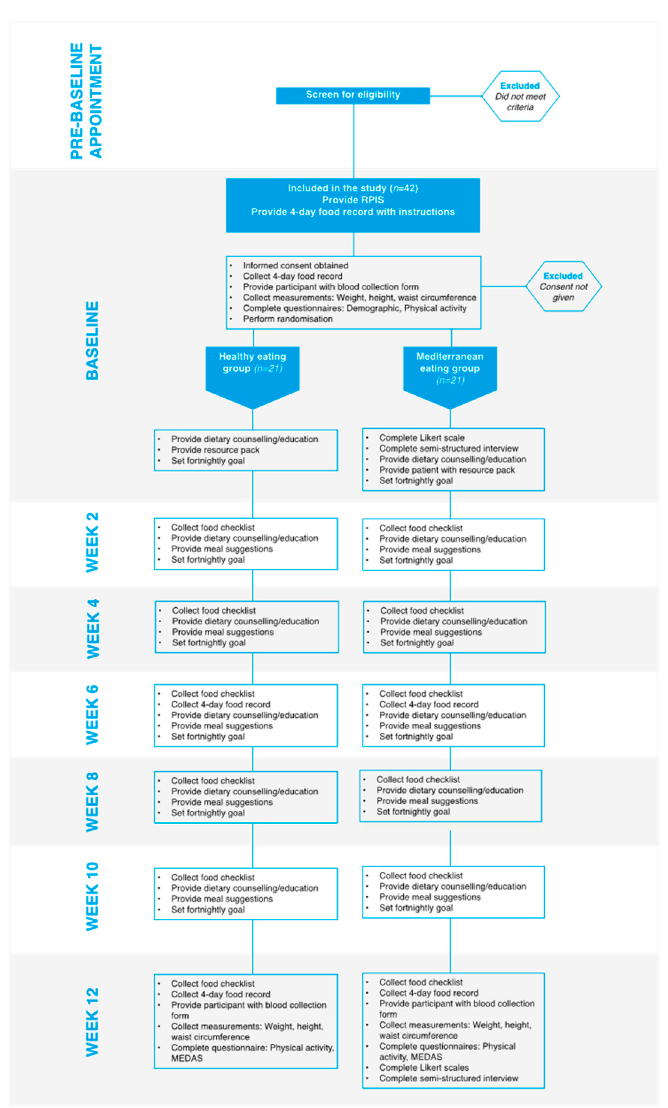
Figure 1. Overview of the study design and schedule.